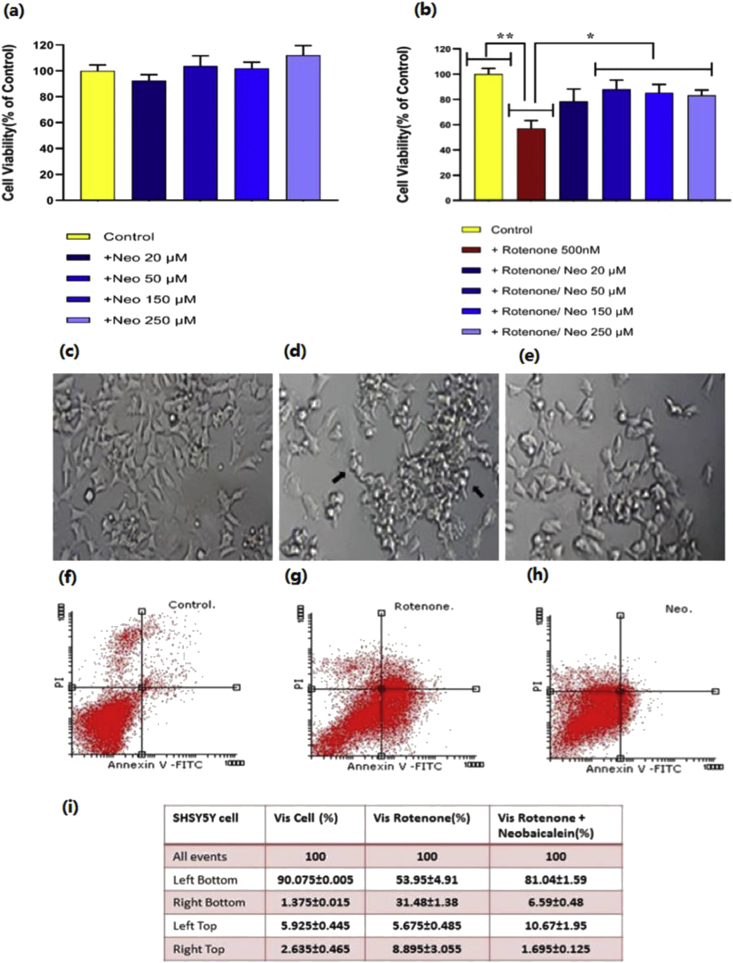
The effect of neobaicalein (Neo) on the viability of the rotenone treated SH-SY5Y cells evaluated by MTT and flow cytometry assays. (a) Different concentrations of neobaicalein (20, 50, 150, and 250 μM) did not induce cell death after 24 h of incubation. (b) Rotenone induced cell death and pre-treatment with neobaicalein, increased cell viability significantly (∗ P-value < 0.05, ∗∗ P-value ≤ 0.01). The morphology of (c) control cells, (d) rotenone treated cells, and (e) neobaicalein/rotenone treated cells. Black arrows show the morphological changes in (d) rotenone-treated cells. Flow cytometry shows the amount of the early apoptosis, late apoptosis/necrosis of (f) control cells, (g) rotenone treated cells, and (h) neobaicalein/rotenone treated cells. In diagrams, the lower left is for live cells, lower right for early apoptotic cells, upper left for necrotic cells, and upper right for late apoptotic/necrotic cells. (i) The table shows the average percentage of the cell count in each quadrant as mean ± SD.